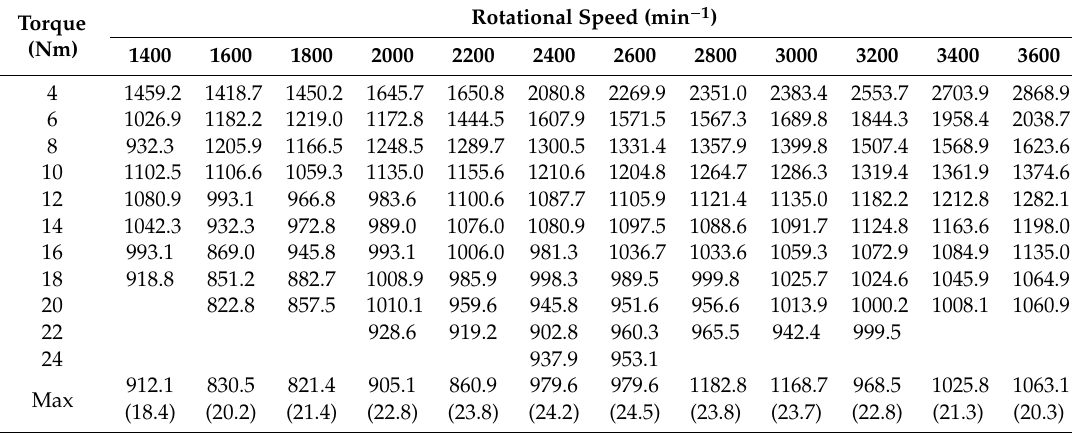
Table A6. CO 2 emission (g / kWh) from range extender supplied with gasoline.